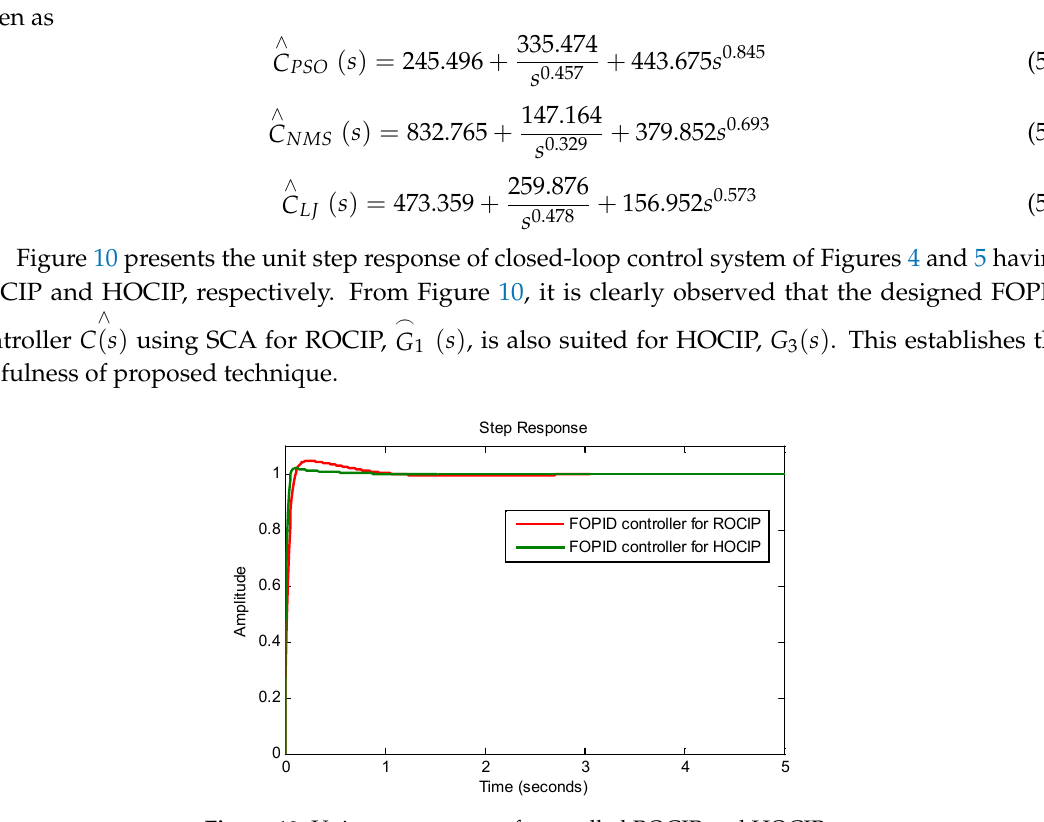
Figure 10. Unit step response of controlled ROCIP and HOCIP.